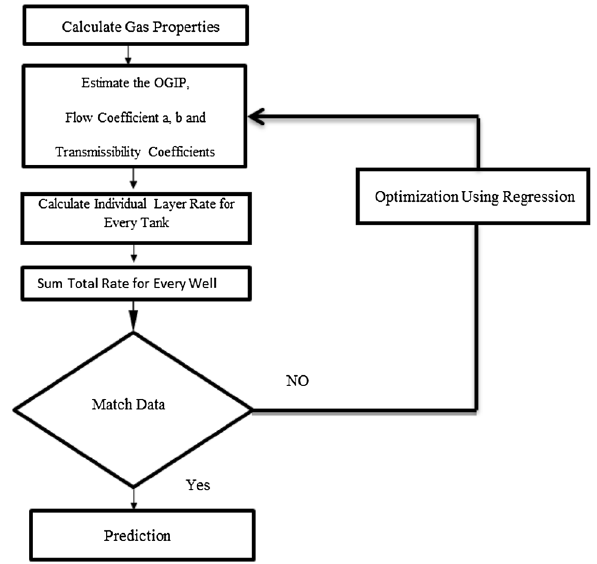
Fig. 2 Flowchart of MCCR model